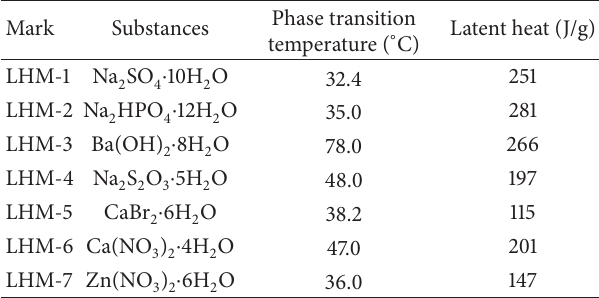
Table 2: Properties of PCMs used in this